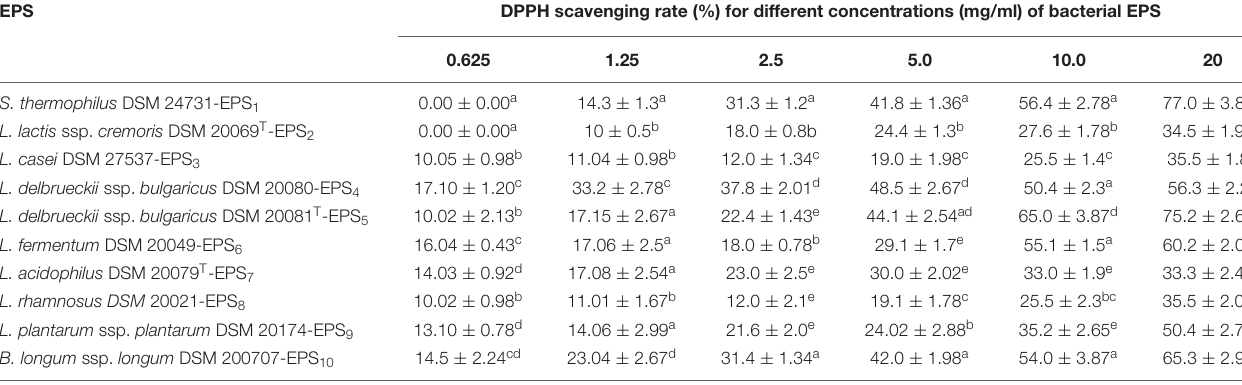
TABLE 2 | Antioxidant activities (%) of EPS derived from LAB and Bb using DPPH radical scavenging